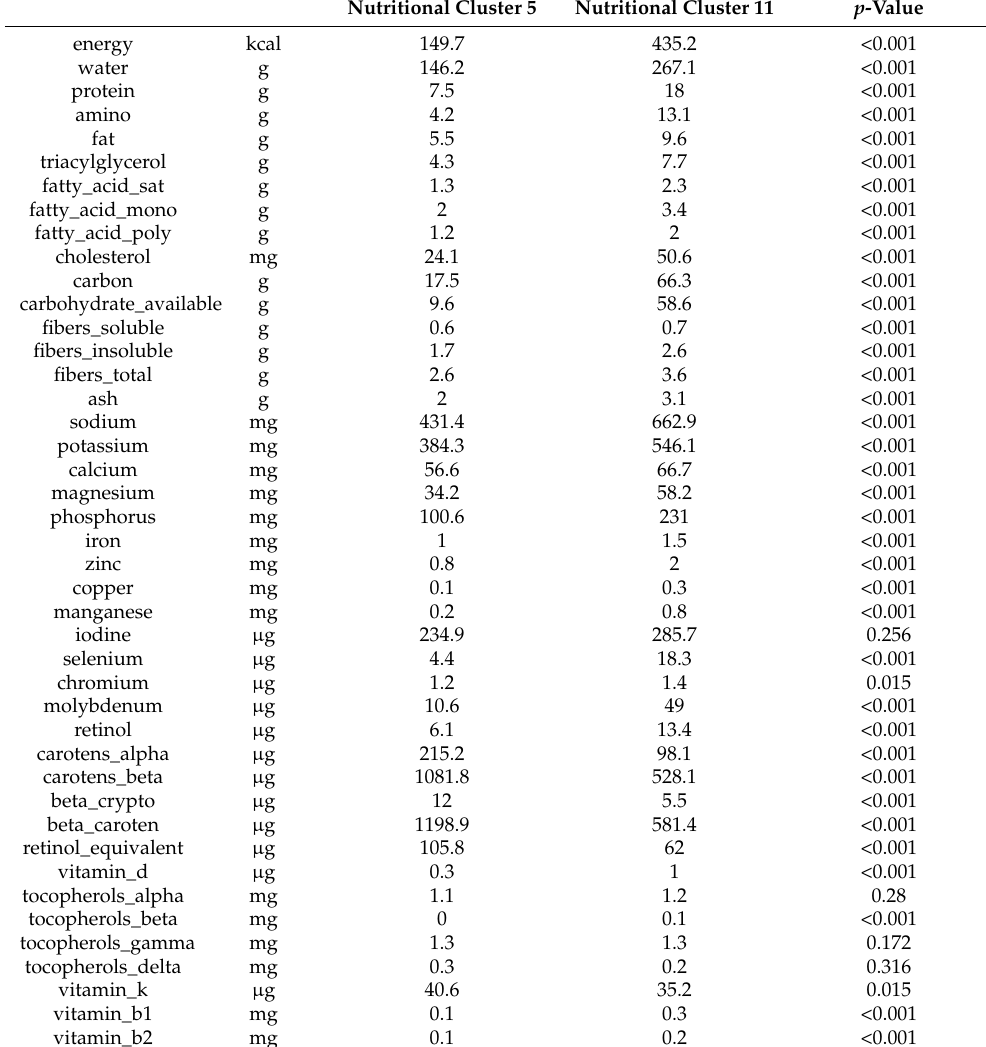
Table 3. Comparison of nutrients in nutritional clusters 5 and